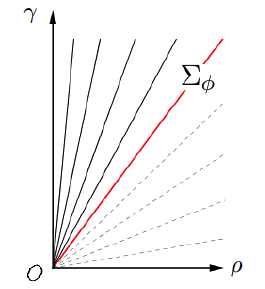
Figure 2. The existence of a minimal slope 1/ Σ in the quadrant φ = constant.